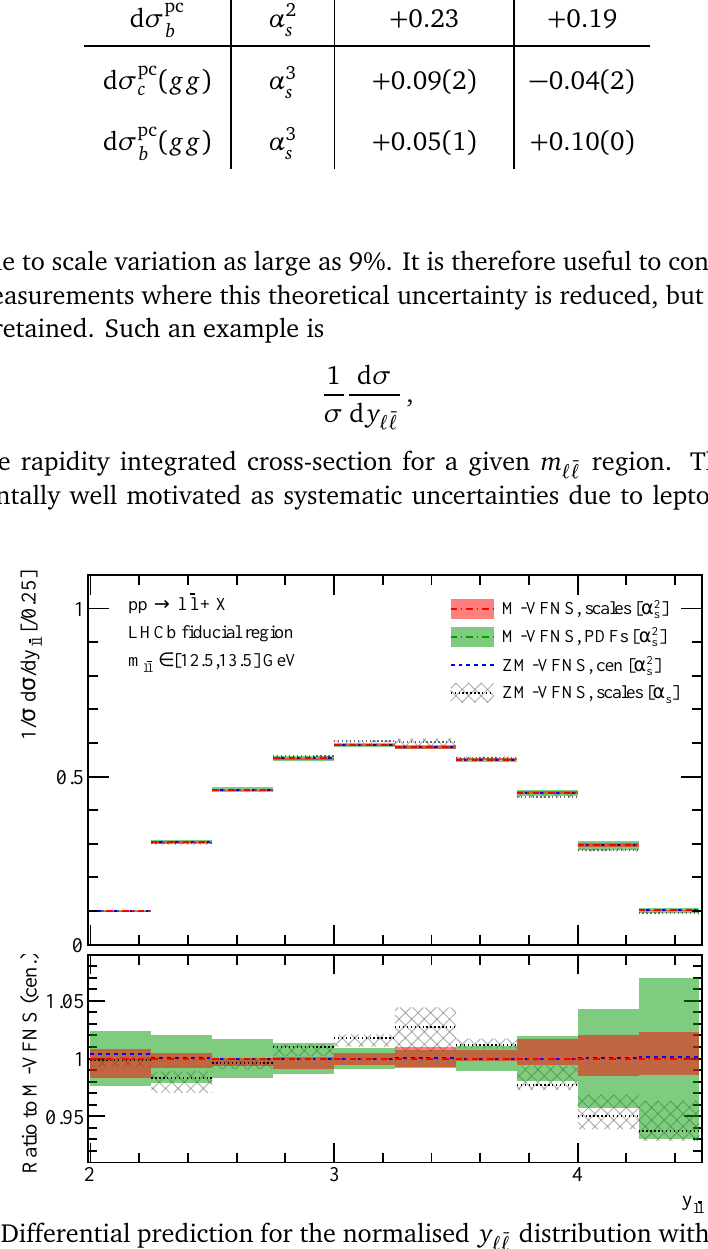
Figure 4: Differential prediction for the normalised y (cid:96) ¯ (cid:96) distribution within the LHCb fiducial region for m (cid:96) ¯ (cid:96) ∈ [ 12.5,13.5 ]